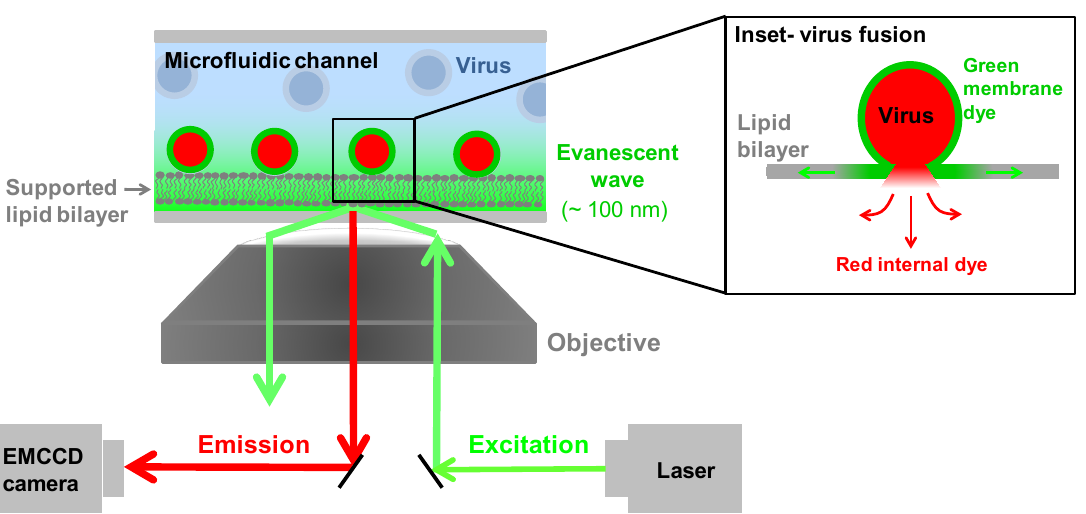
Figure 4. Total internal reflection fluorescence microscopy integrated with a microfluidic device. A coherent laser source can be steered through an inverted microscope objective at or above the critical angle for total internal reflection as dictated by Snell’s law, generating an evanescent wave at the glass-buffer interface. A supported lipid bilayer adsorbed to the walls of the microfluidic device will reside within this evanescent wave. Fluorescently-labeled viruses bound to the supported bilayer will be excited and emit a red signal. The emitted light is sent back to a sensitive camera for imaging. The addition of a second laser line or more allows multiple fluorophores to be monitored simultaneously, for example, one to mark the viral membrane and another to mark the internal contents. Note that the size of the virus with respect to the bilayer is not drawn to scale. The bilayer is ~4 nm thick, while the virus is typically ~100 nm in diameter. (Inset) Upon acidification of the microfluidic channel, virus fusion commences. A two color virus labeling scheme distinguished the hemifusion step (green) from pore formation